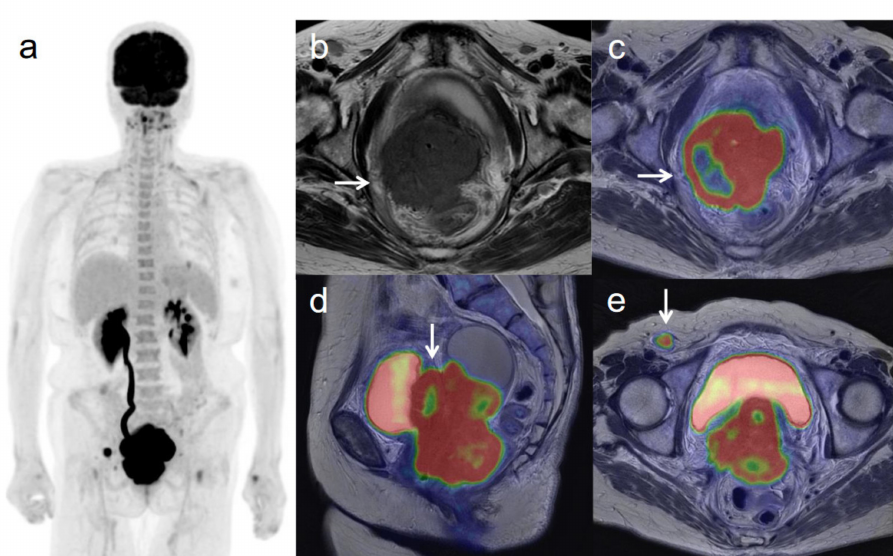
Figure 2. A 62-year-old woman with stage IVB cervical cancer with invasion into the pelvic side wall. ( a ) 18 F-FDG PET image shows FDG uptake by tumor in the cervical cervix (arrow) and a right inguinal lymph node. ( b ) Axial T2-weighted pelvic MR image shows disruption of the right cervical stroma by the tumor and extension into the pelvic side wall (arrow). ( c ) Axial T2-weighted PET/MR image shows FDG uptake by the tumor, which invades the right cervical stroma and extends into the pelvic side wall (arrow). These appearances are consistent with the clinical findings. ( d ) Sagittal T2-weighted PET/MR image shows FDG uptake by the cervical tumor and invasion into the bladder (arrow). ( e ) Coronal T2-weighted PET/MR image shows invasion of the bladder by the cervical tumor and FDG uptake by a right inguinal lymph node (arrow).